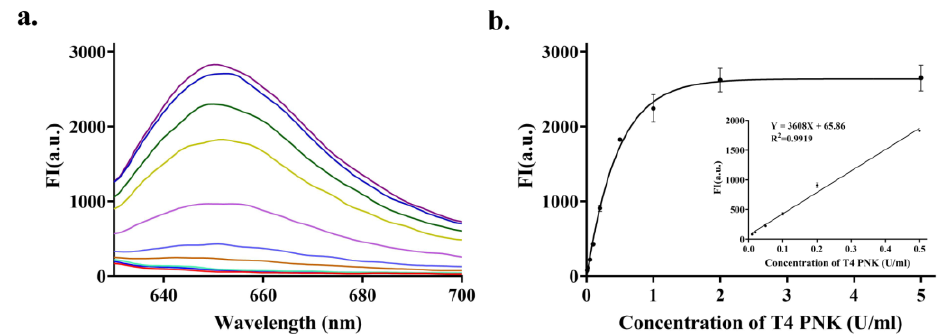
Figure 3. ( a ) Fluorescence emission spectrum of the assay upon addition of different units of T4 PNK (from bottom to top): 0, 0.01, 0.02, 0.05, 0.1, 0.2, 0.5, 1, 2, 5 U/mL. ( b ) Calibration curve for T4 PNK detection. The error bars represent the standard deviation (SD) across three repetitive experiments over the blank response. Table 2. Comparison of the analytical performances of different detection methods for T4 PNK activity. Sensing